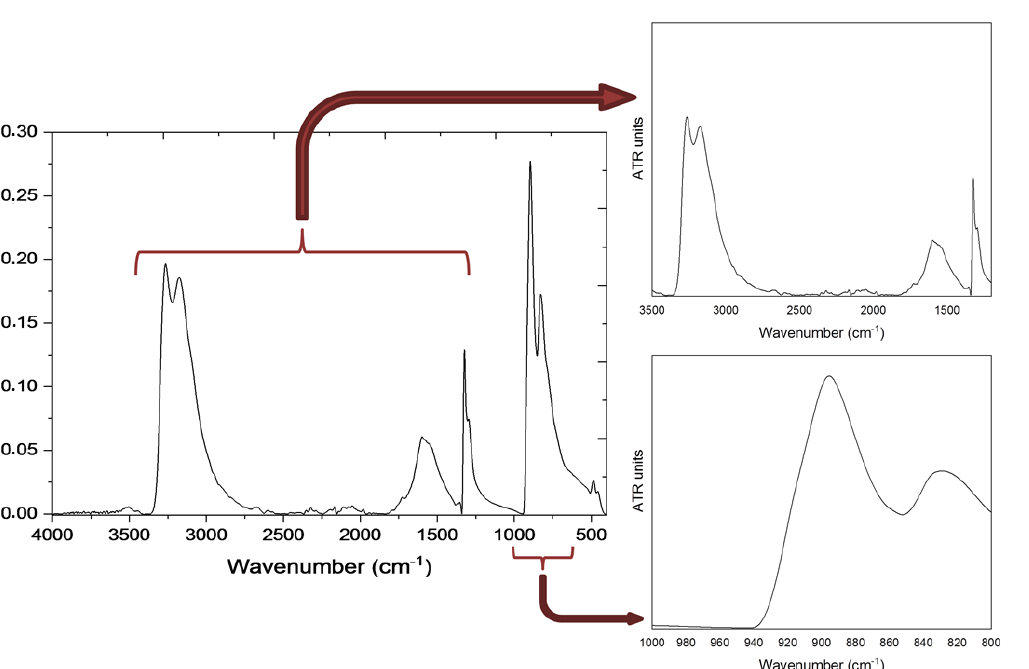
Figure 6. Raman spectra of compound 3-Mn at 298 (red) and 123 K (black) in the range of 1000-200 cm -1. Despite the forbidden nature of ν s (Mn- O) and δ s (Mn-O) modes in T d , 2 and 2 × 2, weak singlet IR bands, respectively, were expected to appear due to the distortion of the MnO 4 – symmetry (C 2v ) and the presence of two sets of permanganate ions in the structure; however, the IR spectrum contained one singlet band at 841 and one at 352 cm −1 , assigned as ν s (Mn- O) and δ s (MnO) modes. The band at 841 cm −1 had a shoulder (Figure 5). The ν s (Mn-O) mode was expected and found to be an intensive band in the Raman spectrum without splitting at room temperature and as two singlets at 123 K, whereas the ν s (Mn-O)